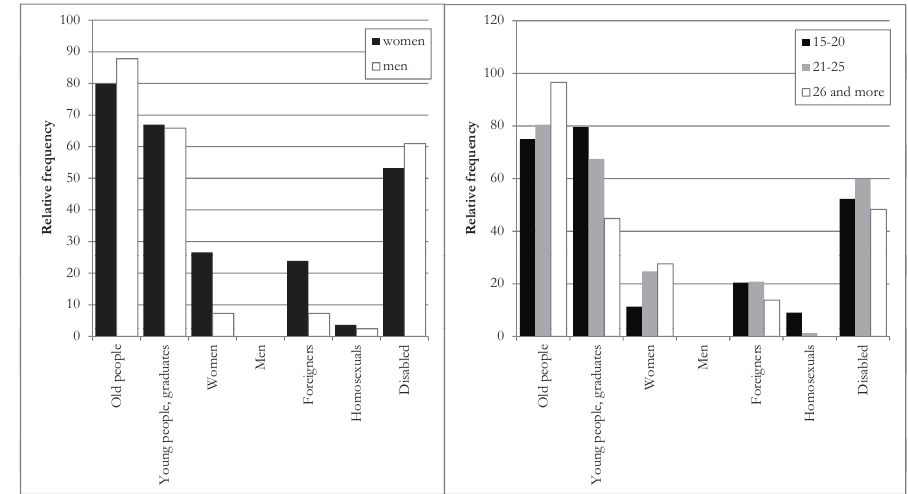
Fig. 6 - The most suffering groups from discrimination by womenm, men and individual age groups. Source: own processing,